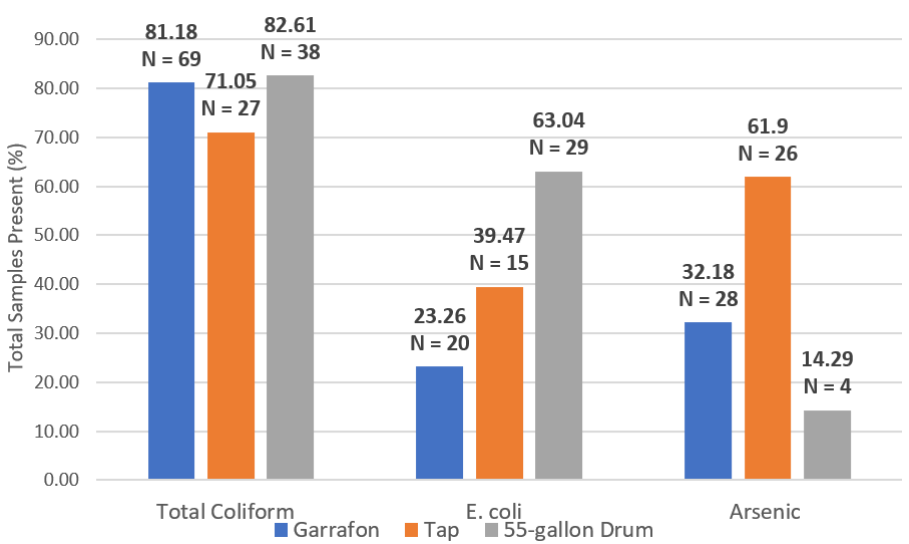
Figure 2. Percent (%) and number (N) of total samples with contaminant present for total coliform bacteria, E. coli and arsenic in 20 L garraf ó n, tap, and 55-gallon drum water